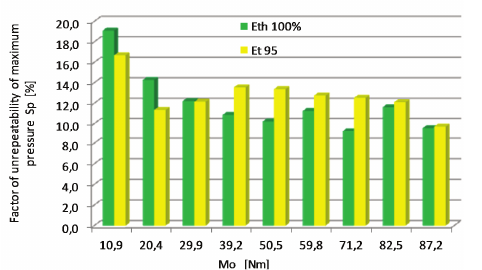
Fig. 6. Comparison of variability factor of maximal combustion pressures in the Fiat 1100 MPI engine fueled with Et 95 gasoline and Eth 100% ethyl alcohol